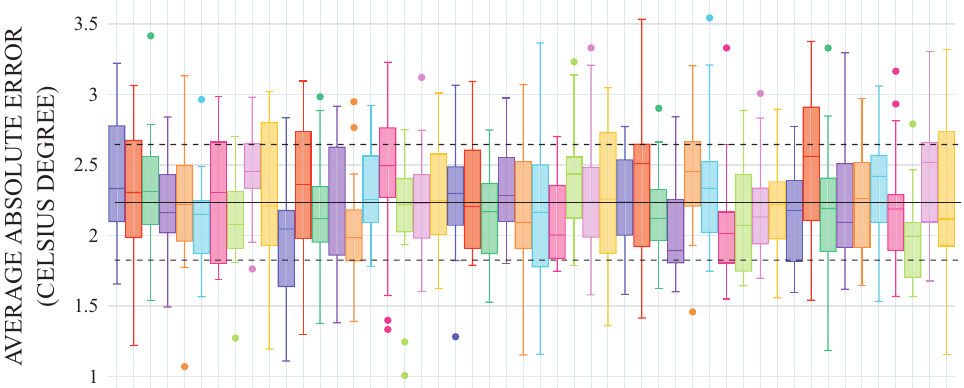
Figure 4. Average absolute error obtained on 50 simulations. The solid black line depicts the average absolute error; the dashed lines represent the standard